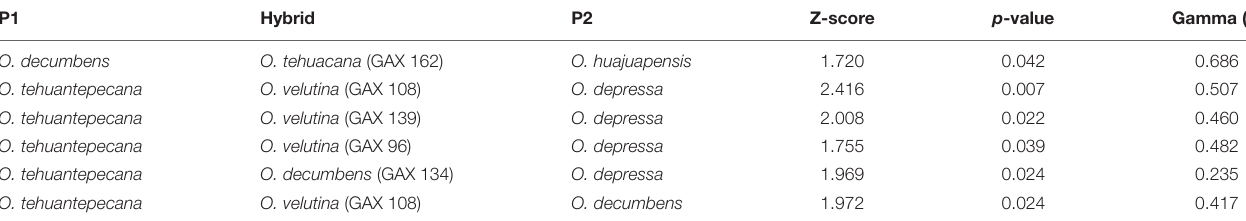
TABLE 5 | Detected hybridization on individuals and their putative parental species in HyDe analysis ( p -values lower than 0.05). P1 Hybrid P2 Z-score p